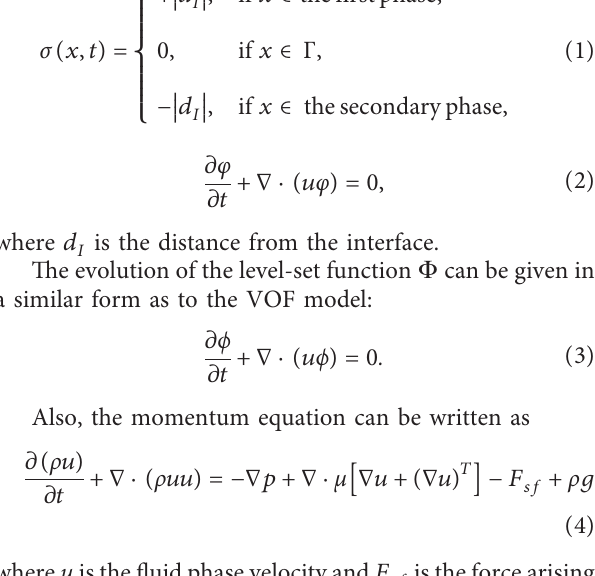
Table 1: The parameters of the numerical